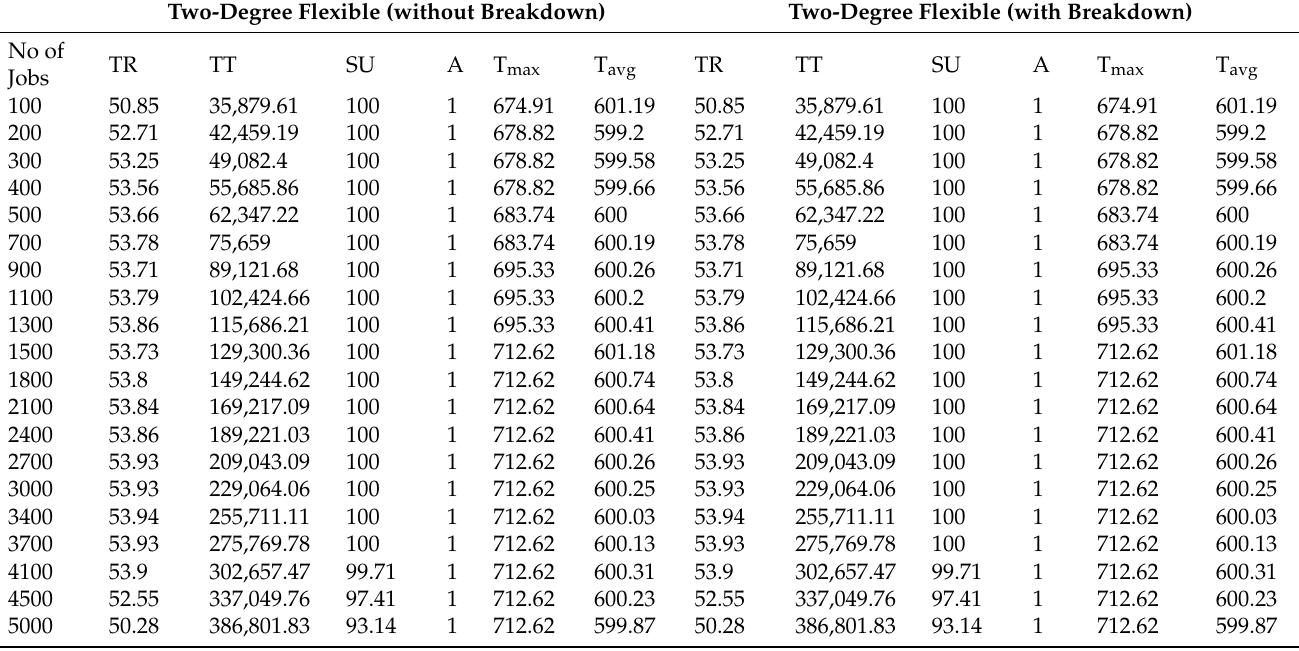
Table 4. Comparative Simulation Matrix of two-degree configuration by without and with breakdown of